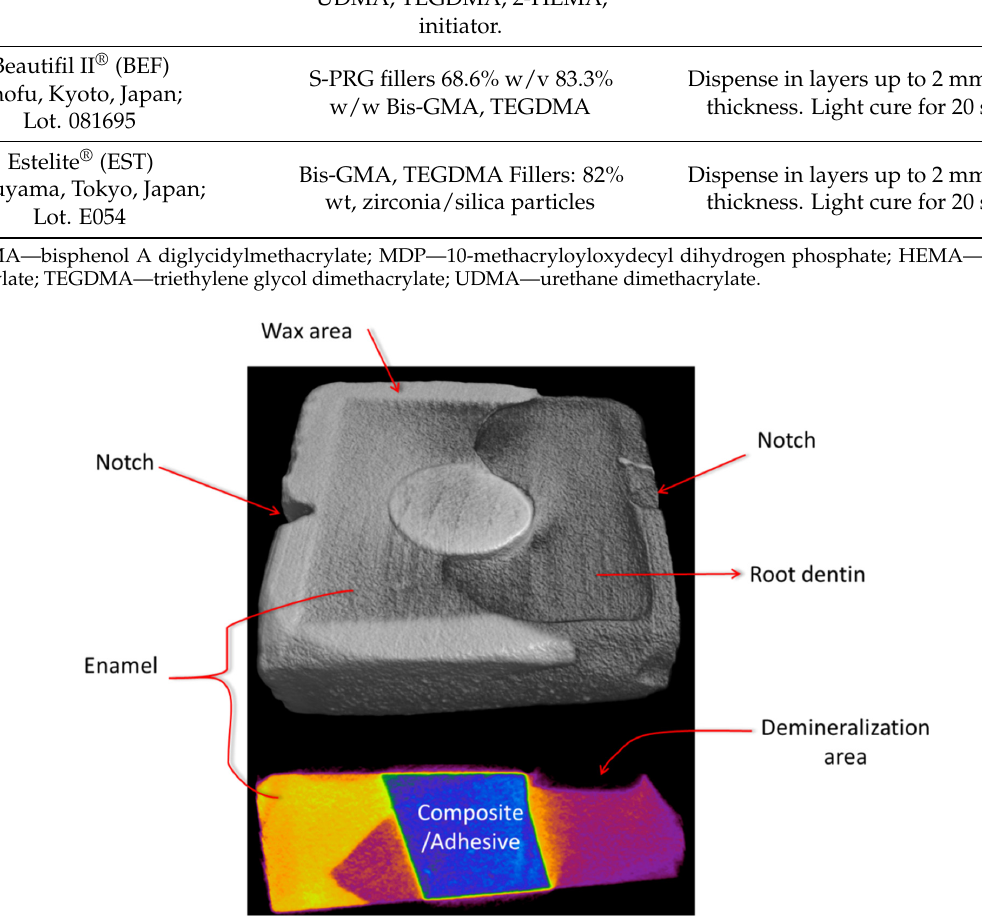
Table 1. Materials used in this study.